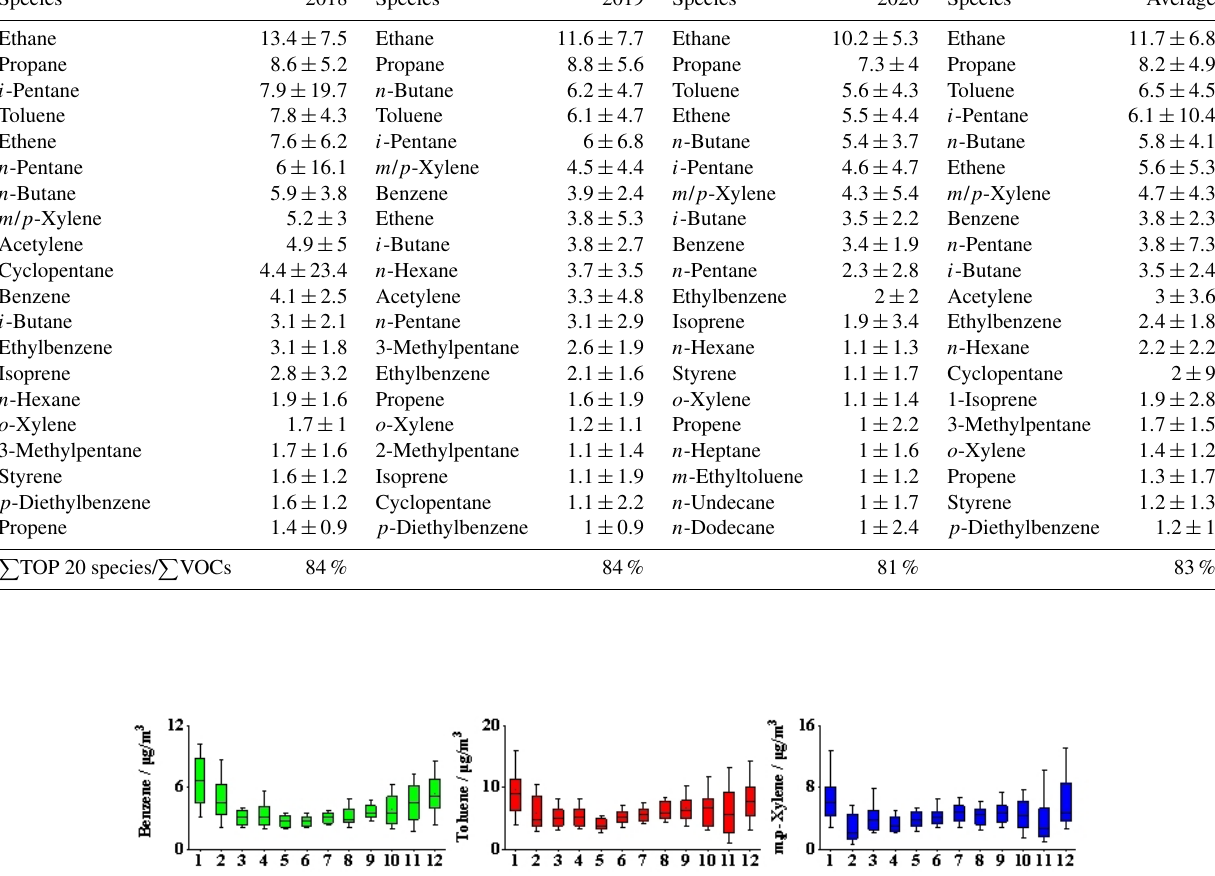
Table 1. Top 20 most abundant VOC species (µgm − 3 ) measured in Zhengzhou for the study period 2018–2020. Species